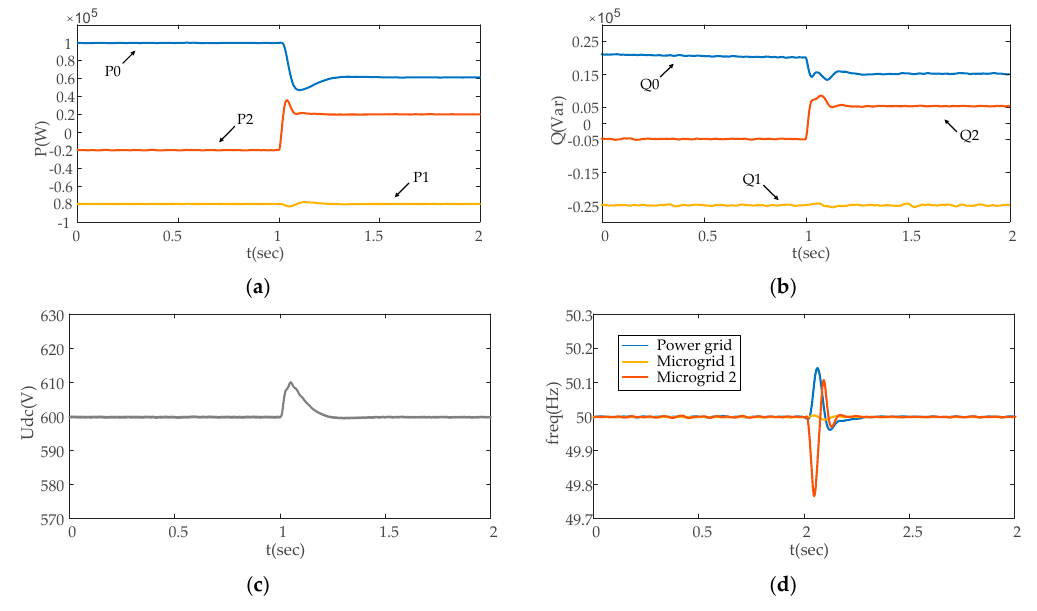
Figure 13. Simulation results of scenario 3: ( a ) active power curves; ( b ) reactive power curves; ( c ) DC-link voltage curves; and ( d ) frequency